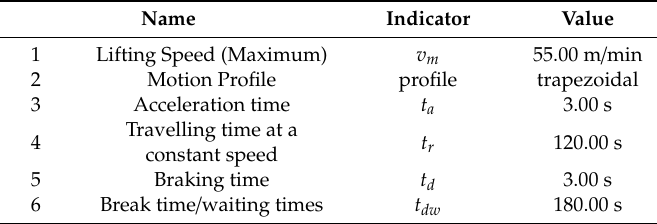
Table 3. Trajectory parameters of the lifting movement.